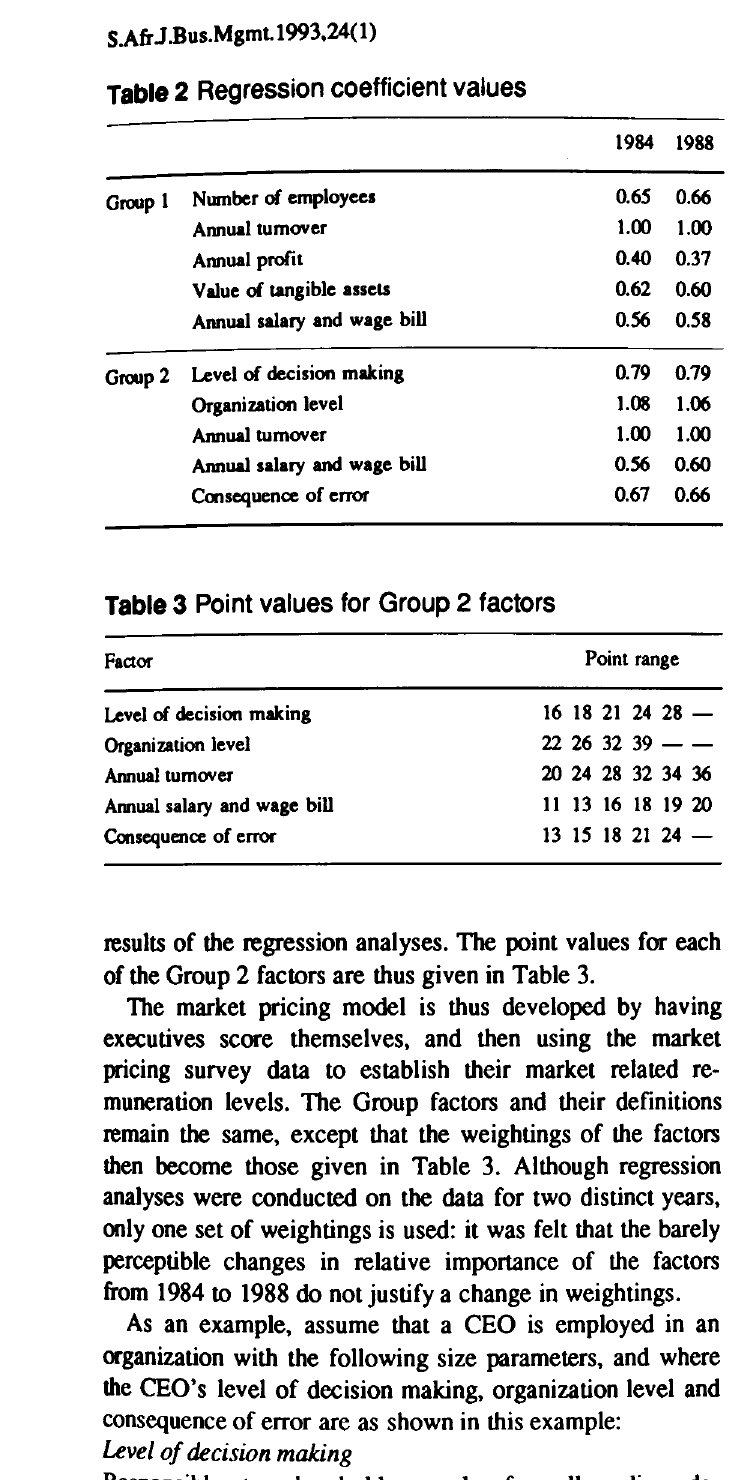
Table 4 Typical presentation of market salary data